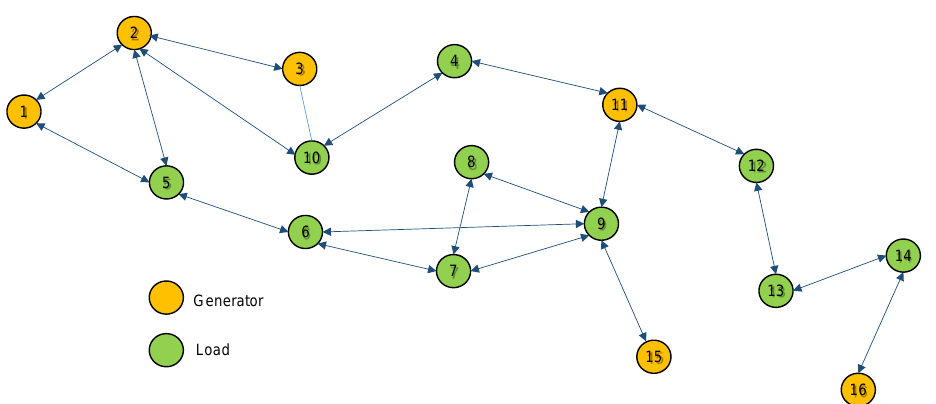
Figure 10. Communication graph for the load restoration example.